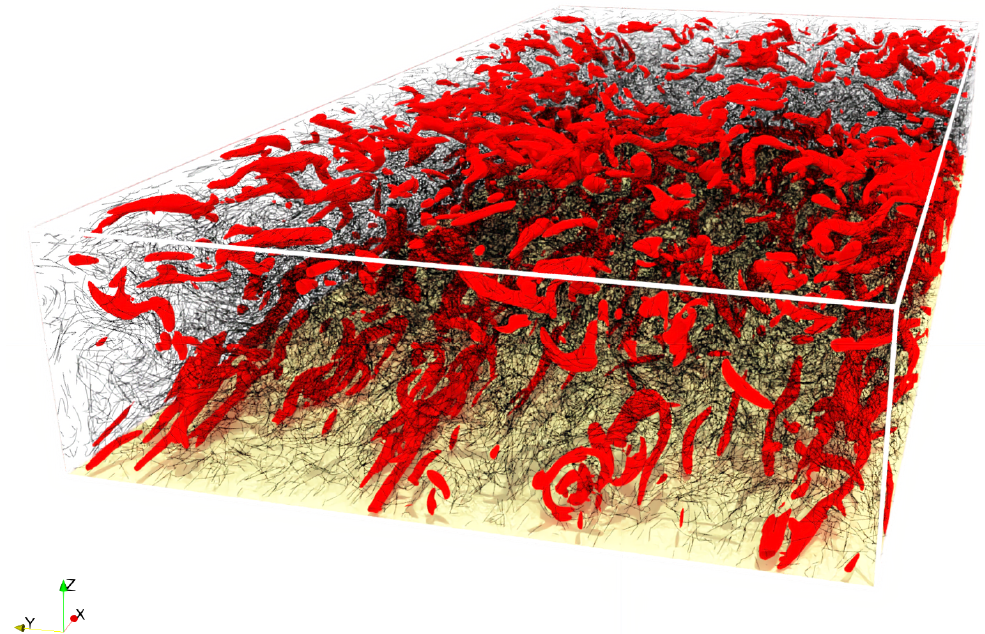
Figure 1. Instantaneous visualization of the fiber-laden turbulent channel flow considered in this study. Flow structures are rendered as iso-surfaces of the second invariant Q of the fluid velocity gradient tensor (the selected value is Q = 0.02, corresponding to one tenth of the maximum value of Q obtained in the simulations); the diameter of the fibers is enhanced by a factor of three for visualization purposes. The upper wall of the channel is transparent for visualization